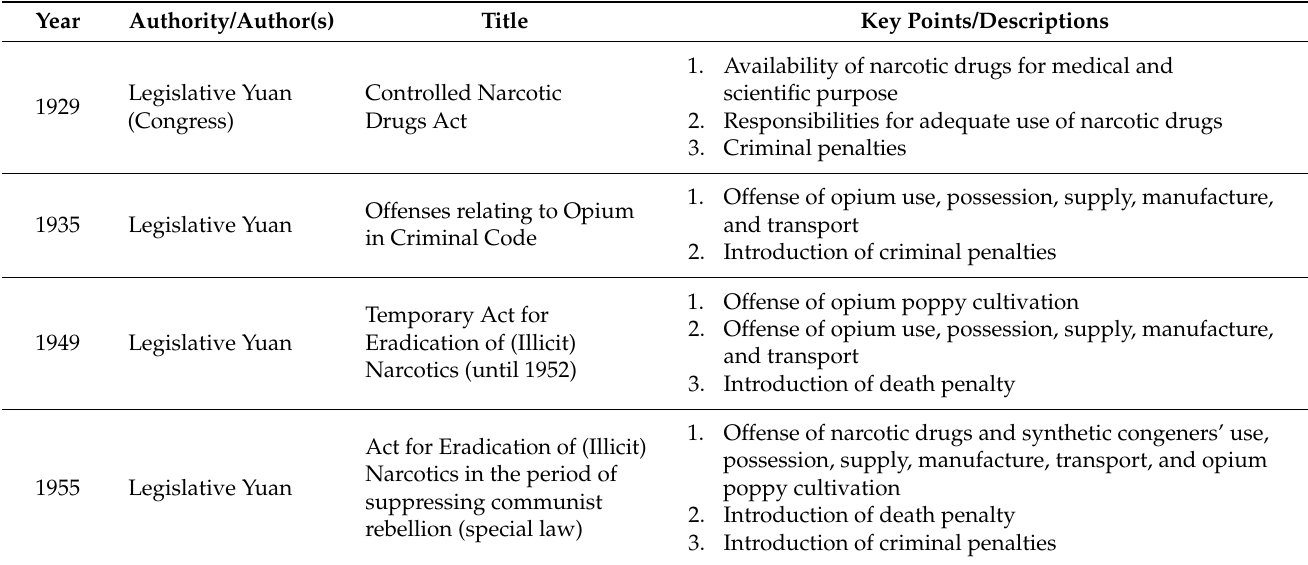
Table 1. Timeline of the associated legislation/regulation documents in